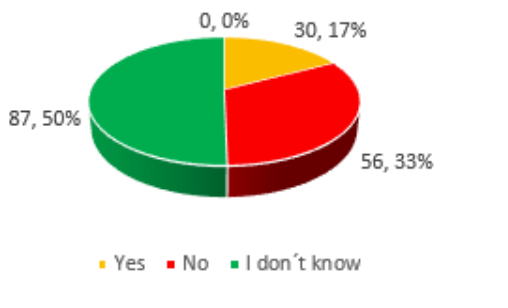
Figure 4. Has geological survey been carried out on your land?